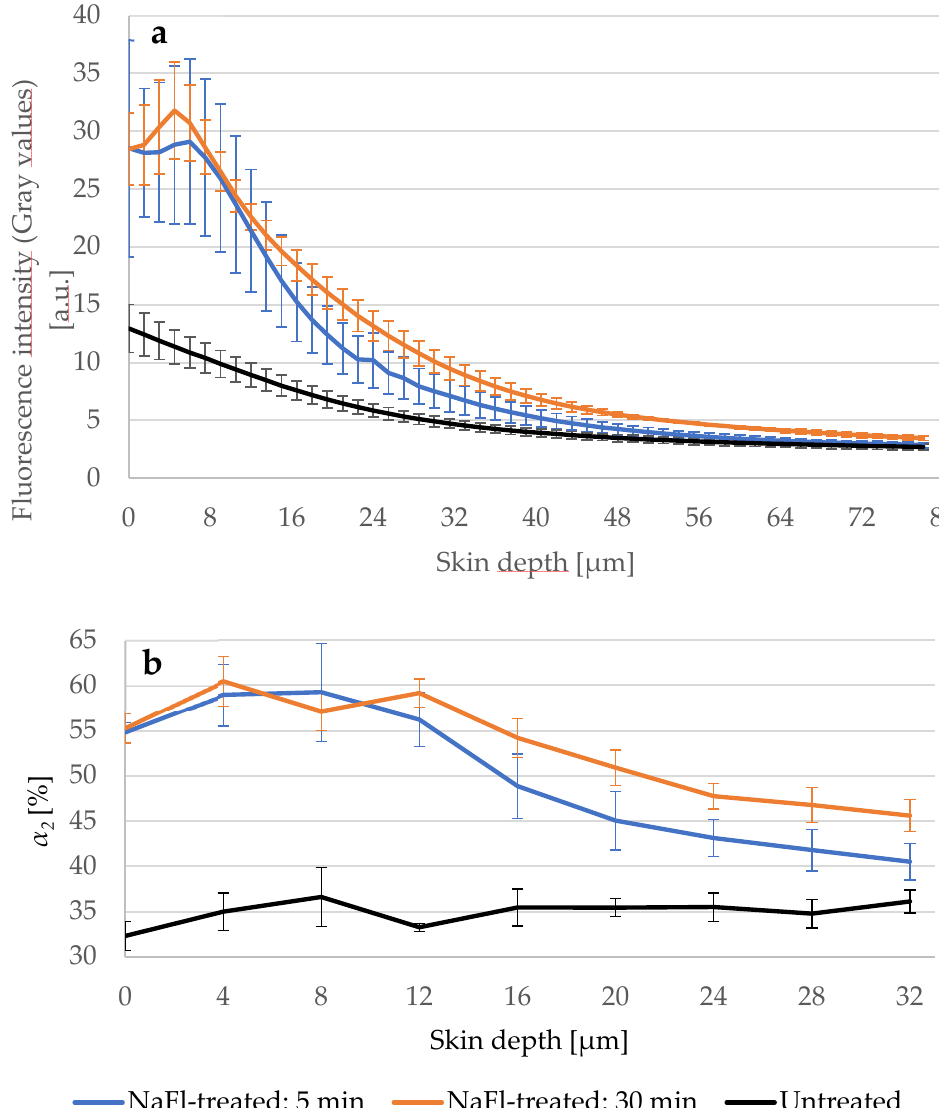
Figure 5. ( a ) LSM-fluorescence intensity of the skin after 5 (blue line) and 30 min (orange line) treatment with NaFl compared to untreated skin (black line). SC -thickness is 16.0 ± 3.3 µ m. Excitation power was fixed at 5 mW. Gray values of LSM images were used as fluorescence intensities. Higher intensity was measured in the 30 min treated sample; ( b ) The relative amplitude of the slow lifetime component α 2 increased after longer treatment time in the viable epidermis. TPE-excitation power shown in Table 1. SC -thickness is 16.0 ± 3.3 µ m. N = 3.